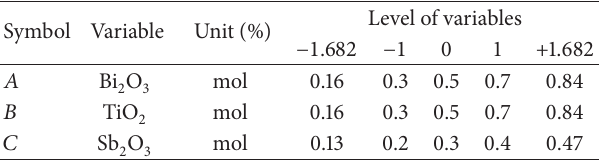
Table 1: Experimental ranges and levels of the effective variables in initial ceramic